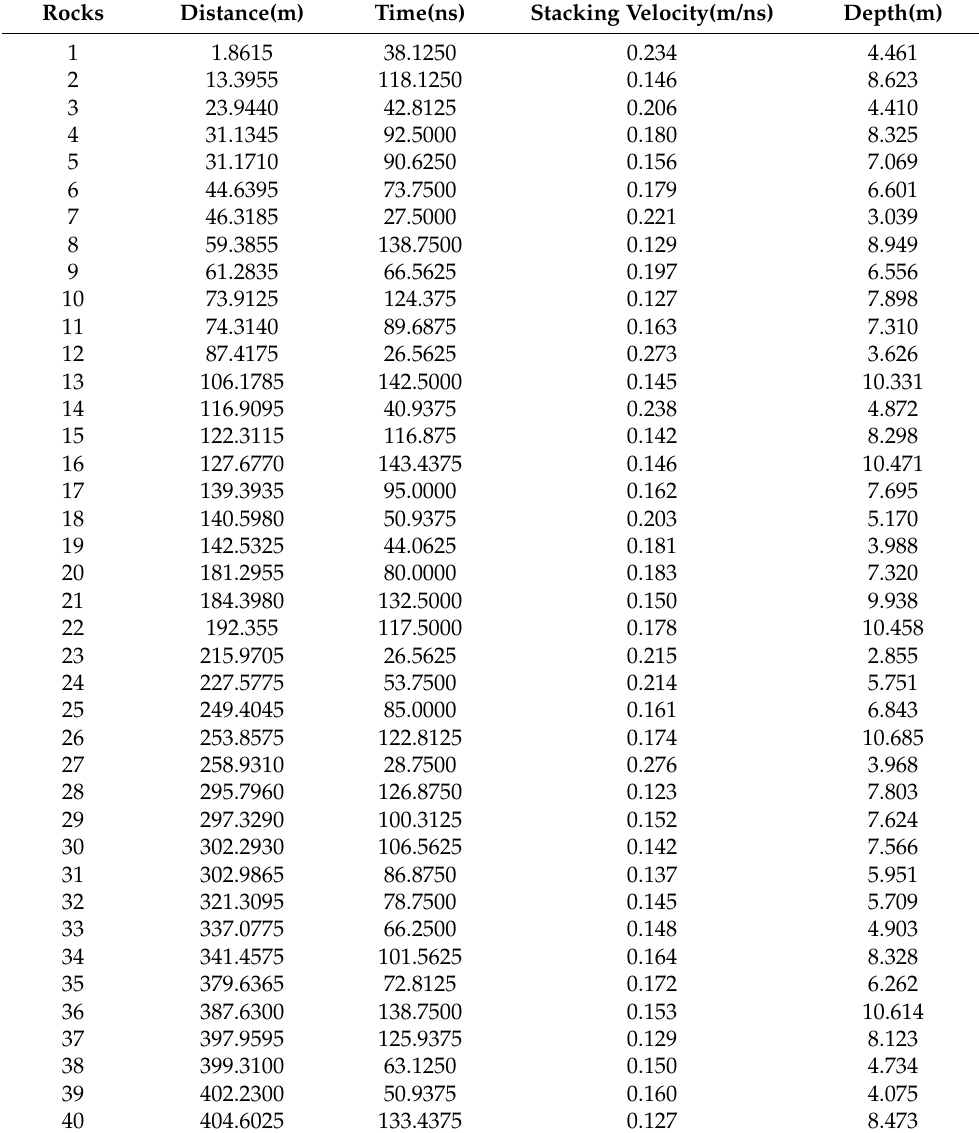
Table 2. The estimated results of velocity and depth for the LPR